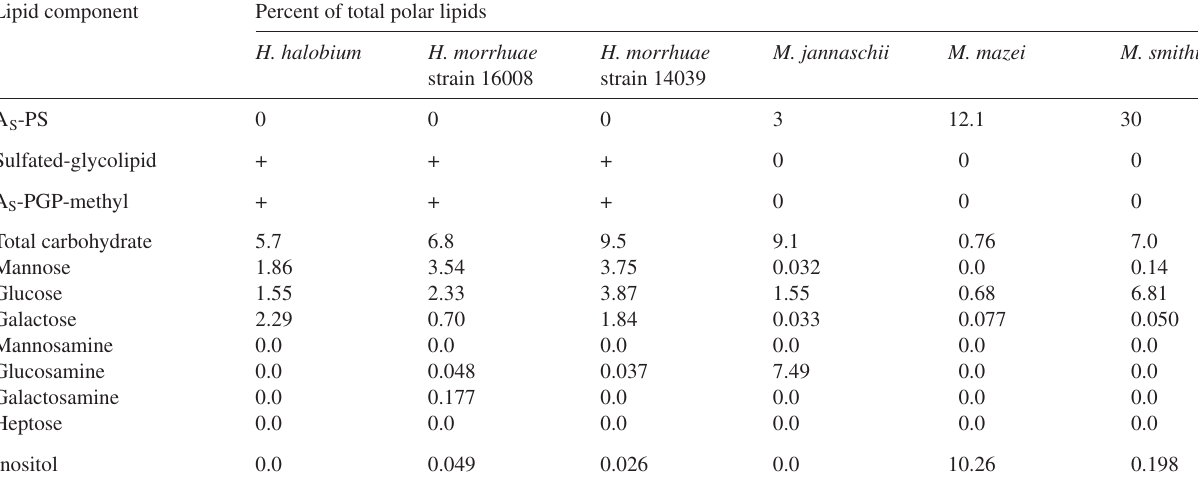
Table 2. Percent relative abundance of lipids and lipid components found in the total polar lipids of archaea. Archaetidylserine (A S -PS) contents are from Sprott et al. (1994, 1999) and Figure 4. Sugars and inositol were identified and quantified as alditol acetate derivatives by GC MS. The relative contribution of each sugar to the total carbohydrate, measured by anthrone reaction, is shown. Archaetidylglycerol methylphosphate (A S -PGP-methyl) and sulfate-glycolipids represent the major lipids of extreme halophiles (+). Of the archaea shown, only M. jannaschii and M. smithii contain